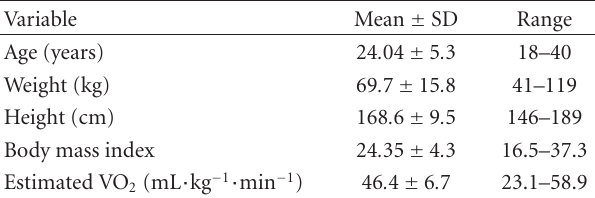
Table 2: Estimated maximum VO 2 relationship with physical fitness measures. Physical fitness measures r value P value Estimated